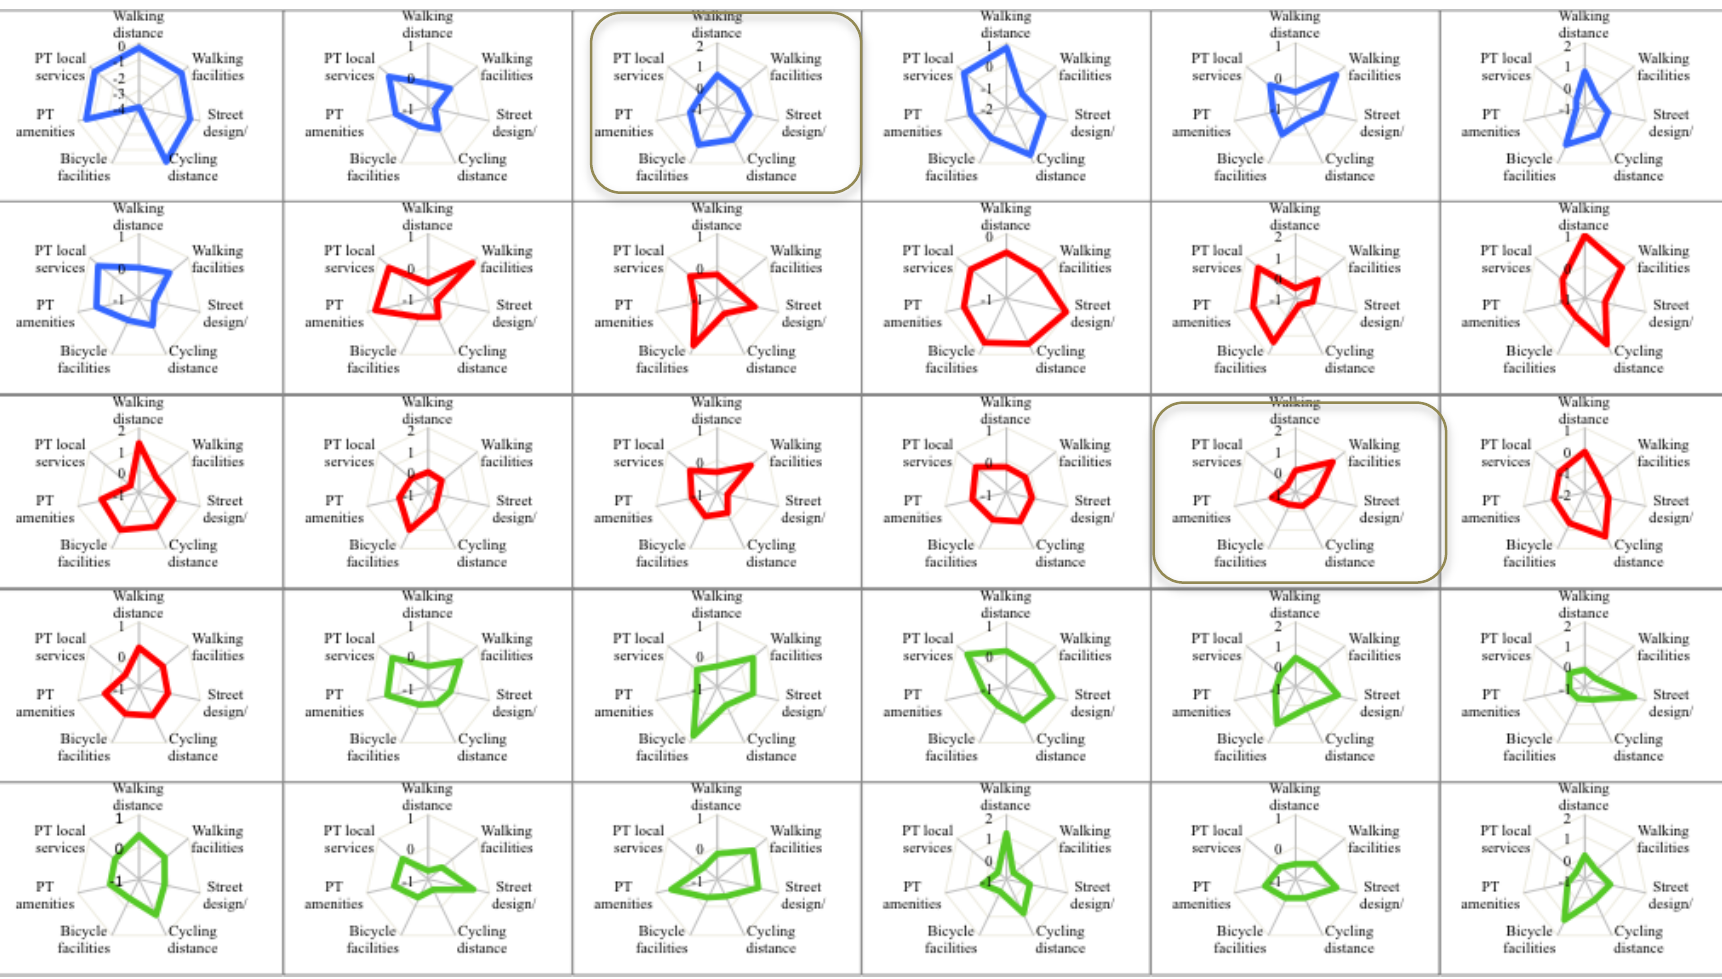
Figure 3. Local accessibility by zone (left to right and top-down, zones 2 to 8 Wellard, 9, 11 to 21 Cockburn Central, 22 to 32 Bull Creek) Note: Colour code: Wellard – blue, Cockburn Central - red, and Bull Creek - green. Zone 1 is a reserve and zone 10 is the local town centre, without residential use and therefore not included in the